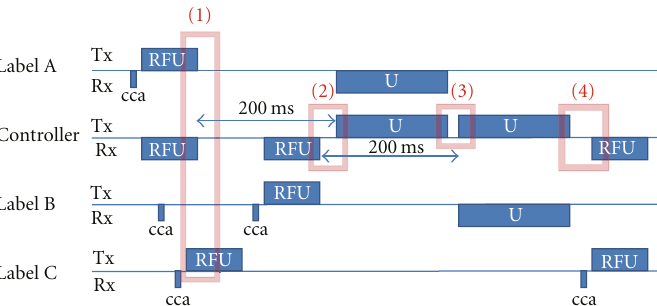
Figure 14: Transmit (Tx) and receive (Rx) timeline for one controller and three labels. Labels send a request for update (RFU) to the controller, the controller replies with an Update (U) after 200ms. Four potential collisions of messages are